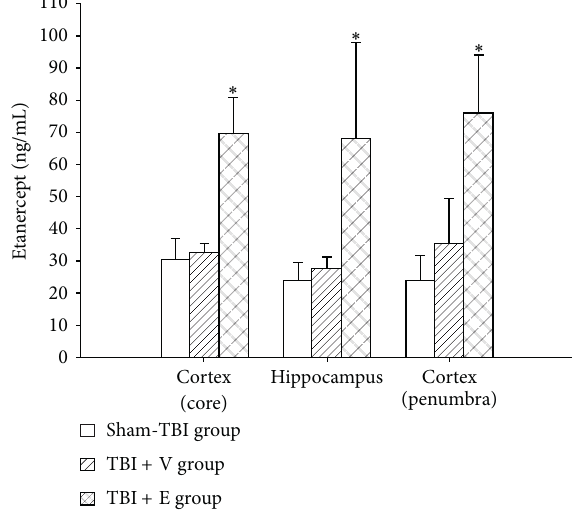
Figure 6: Mean ± standard deviation values of the concentrations of etanercept detected in the ischemic brain regions for the sham- TBI group (white column), the TBI + V group (lined column), and the TBI + E group (crossed column). (See the legend of Figure 1 for group abbreviations). The data were obtained 7 days after TBI or sham-TBI operation ( 𝑛 = 8 ). ∗ 𝑃 < 0.05 compared the TBI + V group or the sham-TBI